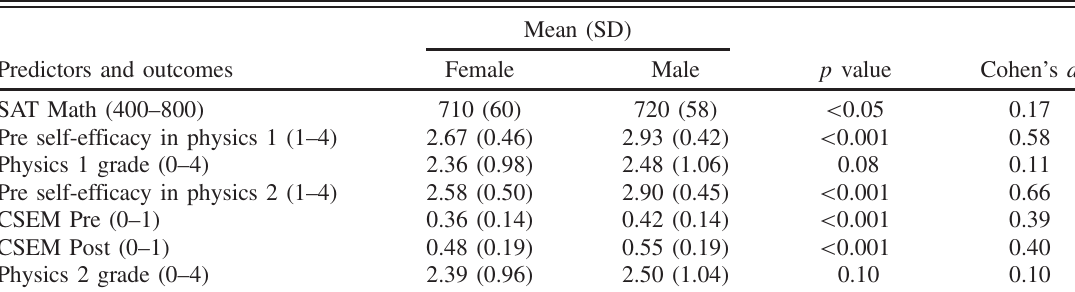
TABLE IV. Means (and standard deviations) of predictor and outcome variables by gender, along with statistical significance ( p values after t test) and effect sizes (Cohen ’ s d ) for the gender contrast. Theoretical score ranges for each variable are also shown.